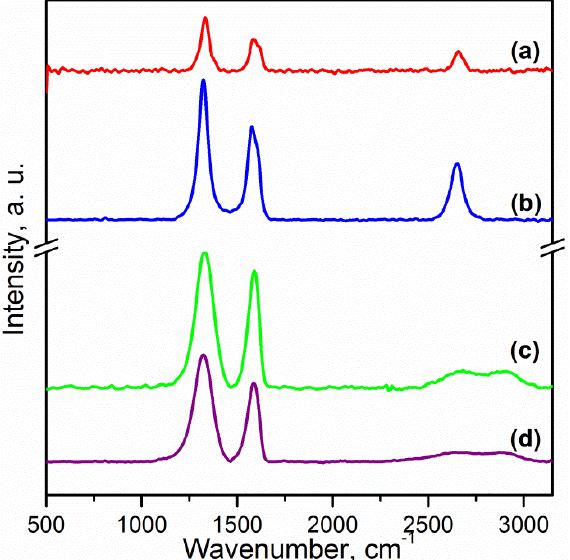
Figure 2. Raman spectra of: ( a ) CNTs; ( b ) OCNTs; ( c ) RGO and ( d ) GO.